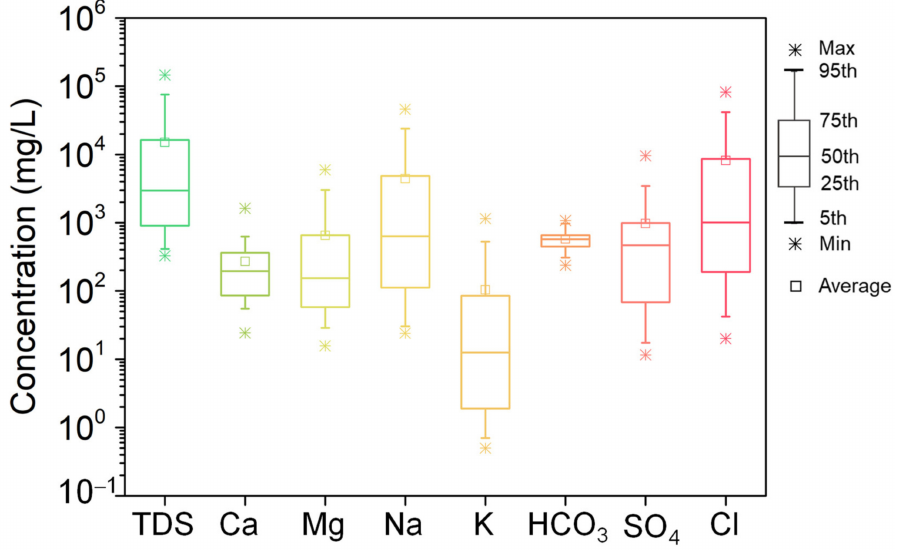
Figure 2. Box plot of major hydrochemical